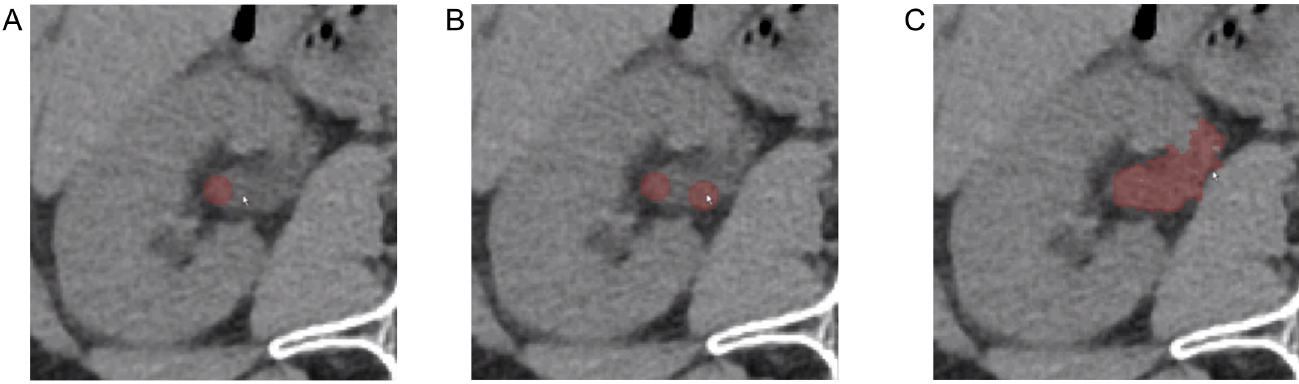
Figure 1. A-C. Circle footprints placed within PCS on the axial slice and the definition of PCS border. A, first-point position; B, second-point position; C, last-point position and proposed PCS border designation. PCS, pelvicalyceal